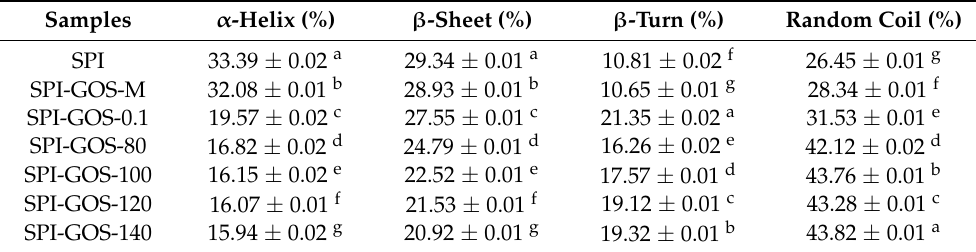
Table 1. Secondary structure composition of glycated SPI formed at different